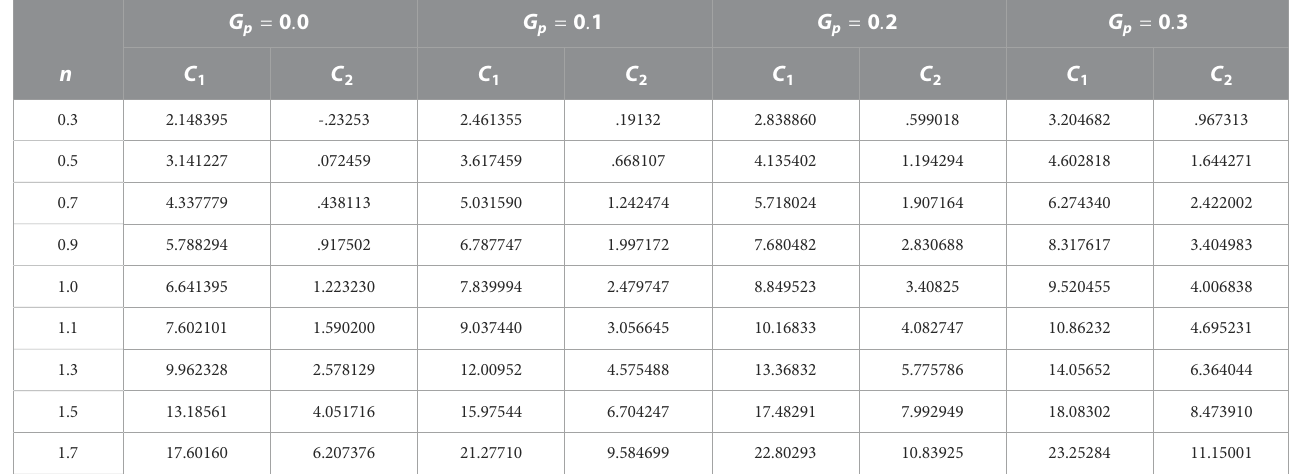
TABLE 4 In fl uence of the drag coef fi cient of both cylinders against n with various gap